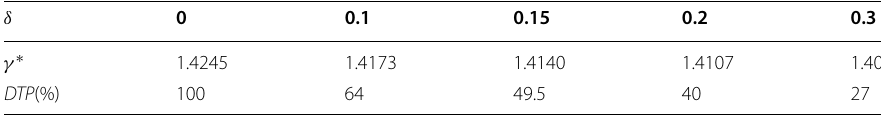
Table 1 Dissipative performance γ ∗ and data transmission performance δ